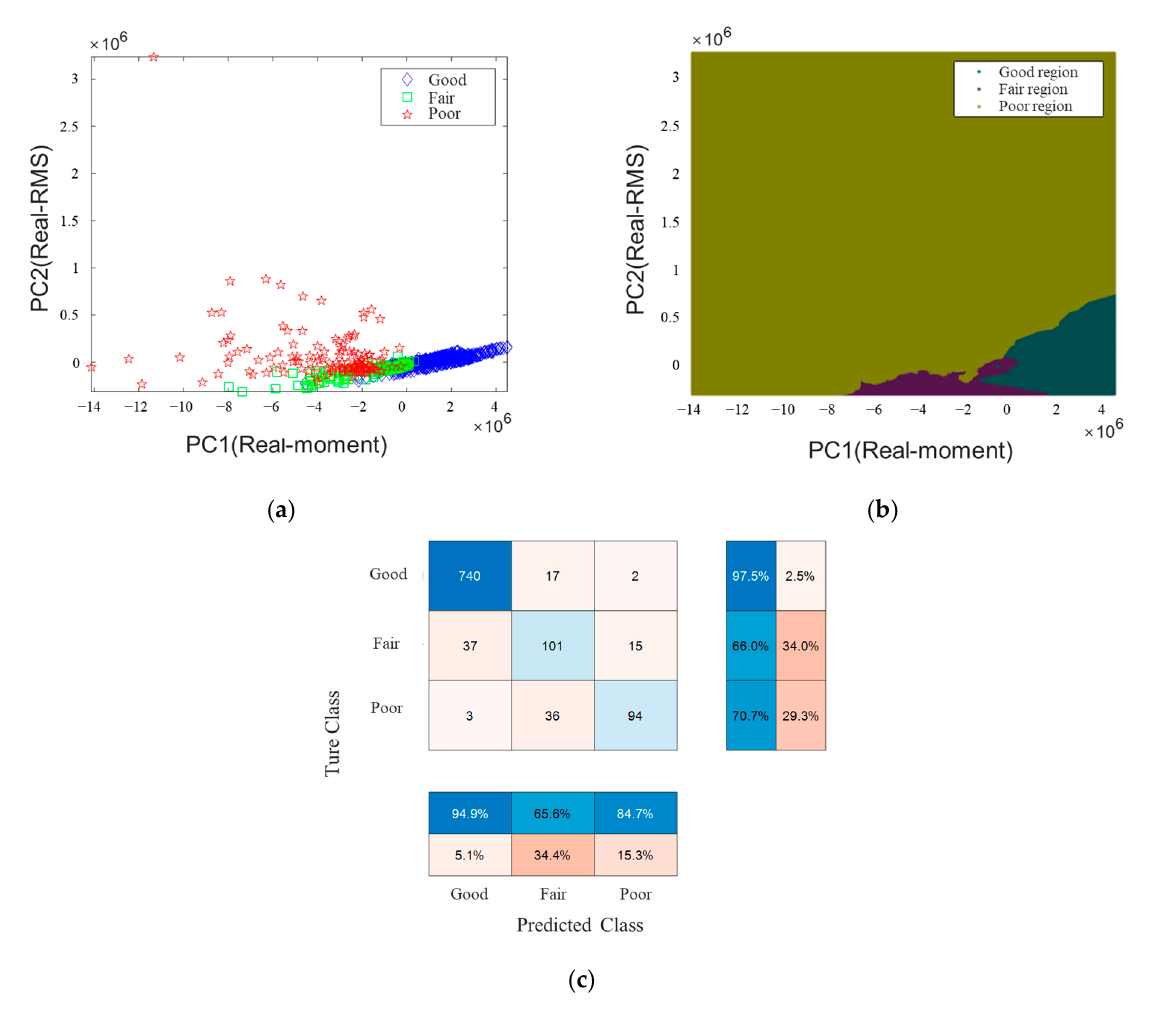
Figure 10. Predicted region and confusion chart through the SL model: ( a ) 2D plots of the full data used for training and validation; ( b ) regions of three labels predicted by SL; ( c ) prediction accuracy of the SL model.